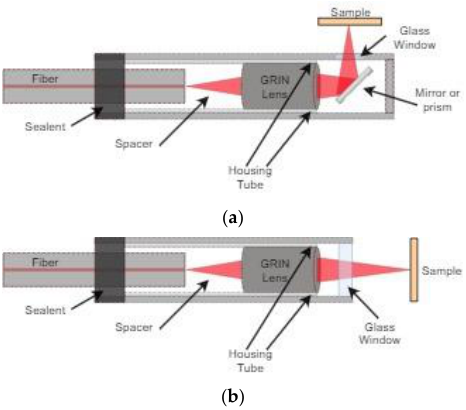
Figure 11. Schematic diagram: ( a ) side viewing probe; ( b ) forward viewing probe.